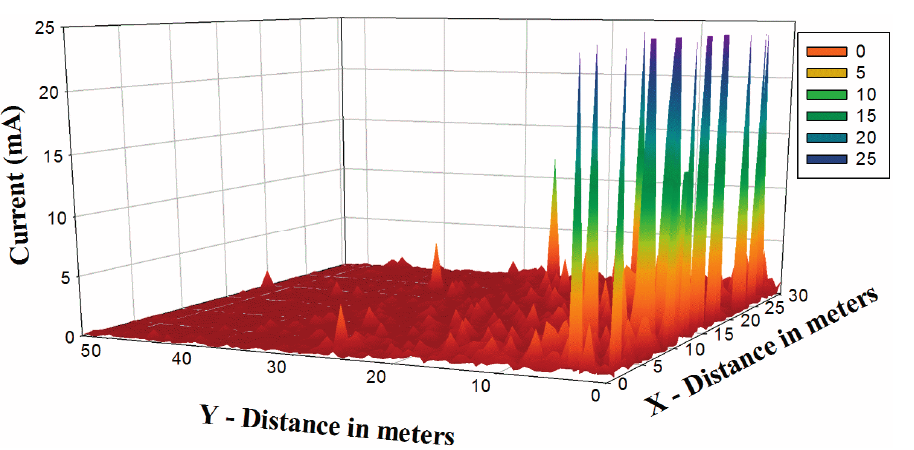
Figure 9. Estimation of energy consumption in terms of current values in